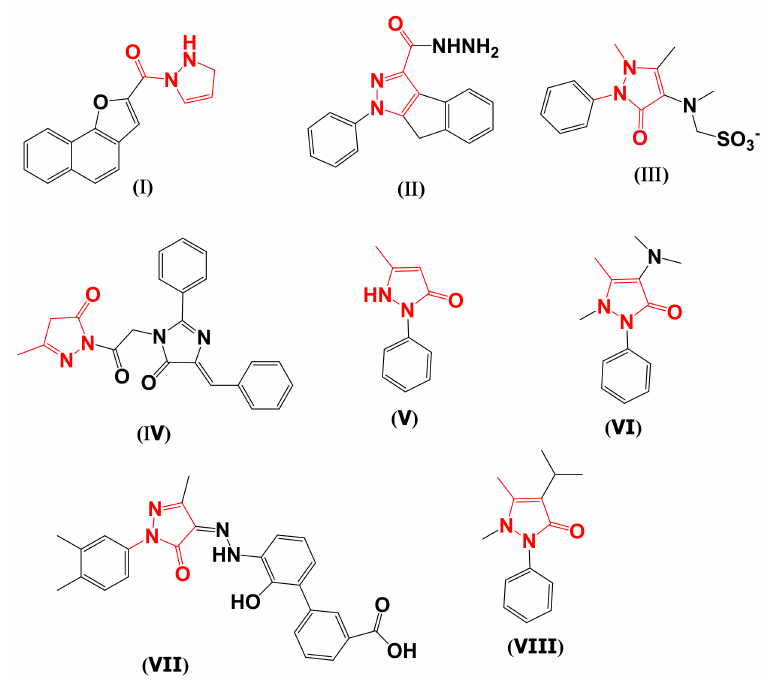
Figure 1. Examples of biologically active